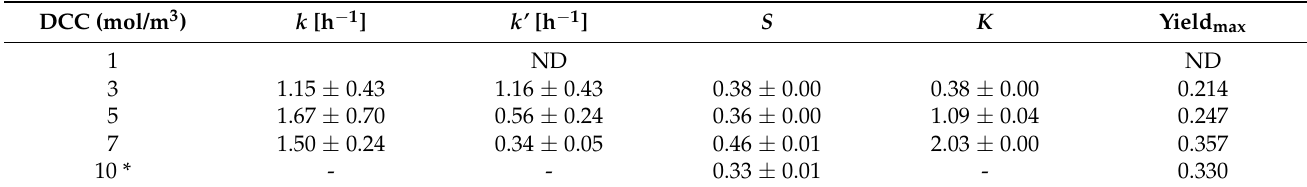
Table 1. Effect of DCC concentration on dipeptide synthesis ( w 0 = 28, pH = 5).